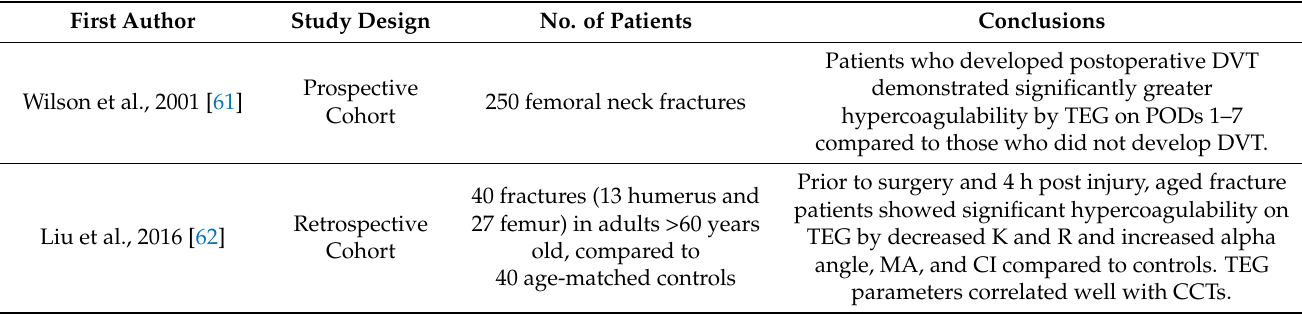
Table 3. Summary of the literature pertaining to viscoelastic hemostatic assays applied for the treatment of patients with long bone